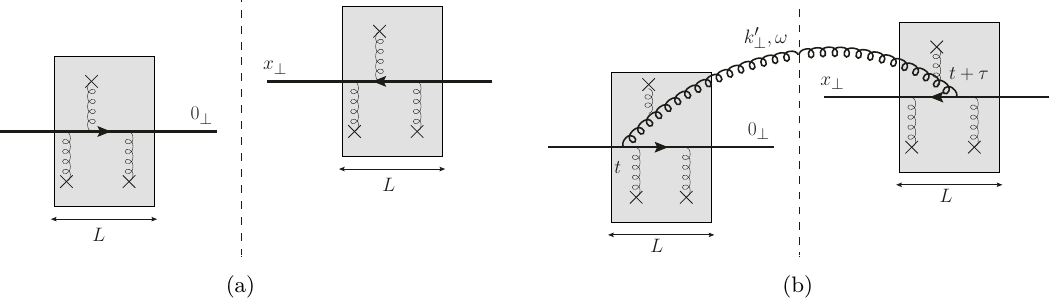
Figure 1. (Left) An illustration of a tree-level diagram [49] contributing to Transverse momentum broadening (TMB), where vertical gluons depict multiple scatterings between the incoming quark and the medium scattering centers. The dotted vertical line represents the cut between the ampli- tude and its complex conjugate (c.c.). (Right) Typical NLO correction to the tree-level distribution due to the radiation of a real gluon of light-cone energy ω and transverse momentum k 0 transverse vector x ⊥ is the difference in transverse position of the quark in the amplitude and its c.c. It is the Fourier conjugate of the measured transverse momentum